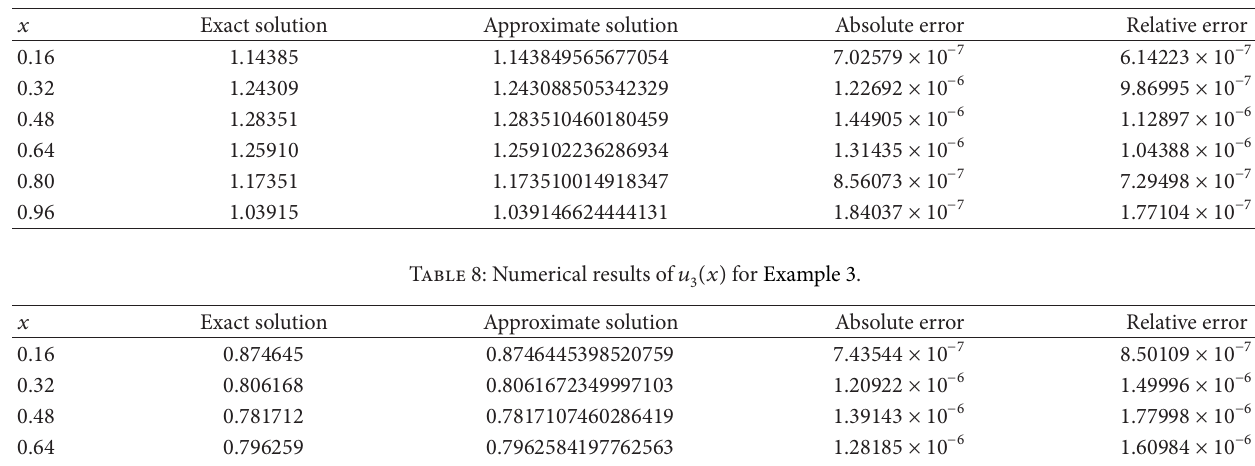
Table 7: Numerical results of 𝑢 2 (𝑥) for Example 3.